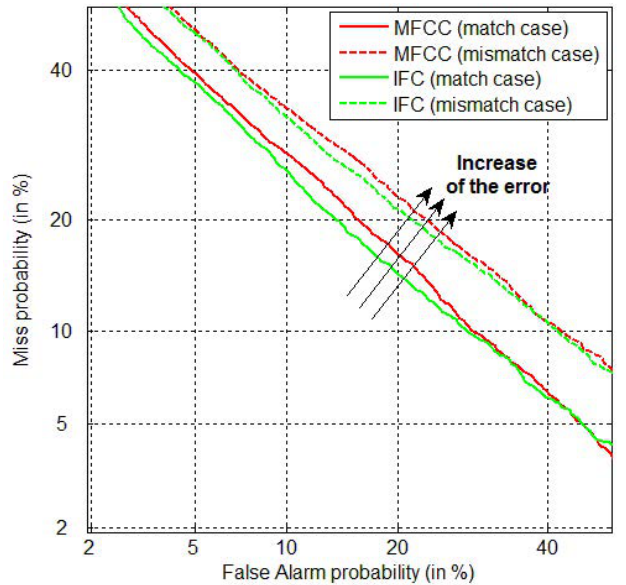
Figure 6. DET curves showing the performance degradation effect in the mismatch case (dashed graphs) compared to the match case (continued graphs).